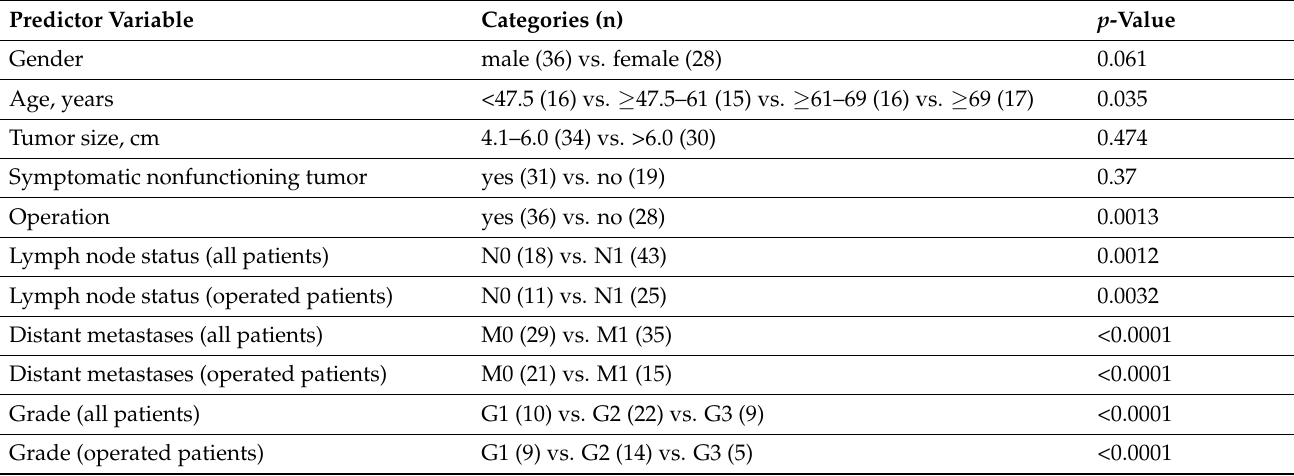
Table 3. Distribution of the predictor variables and results of univariate analysis for overall survival.